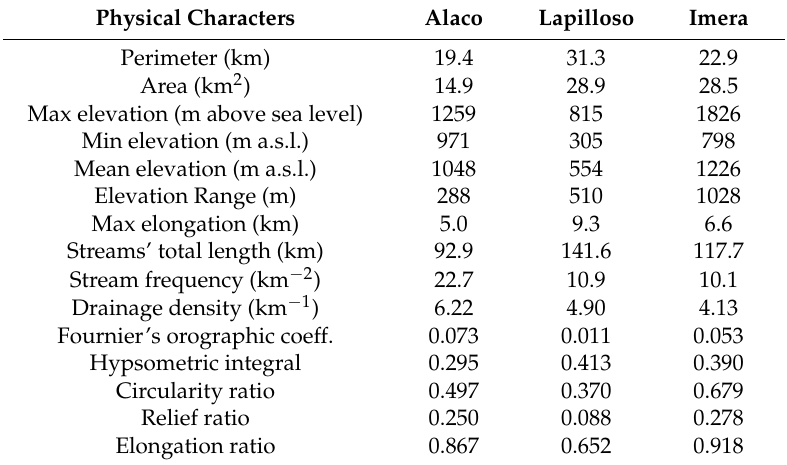
Table 1. Morphometrics of selected catchments.